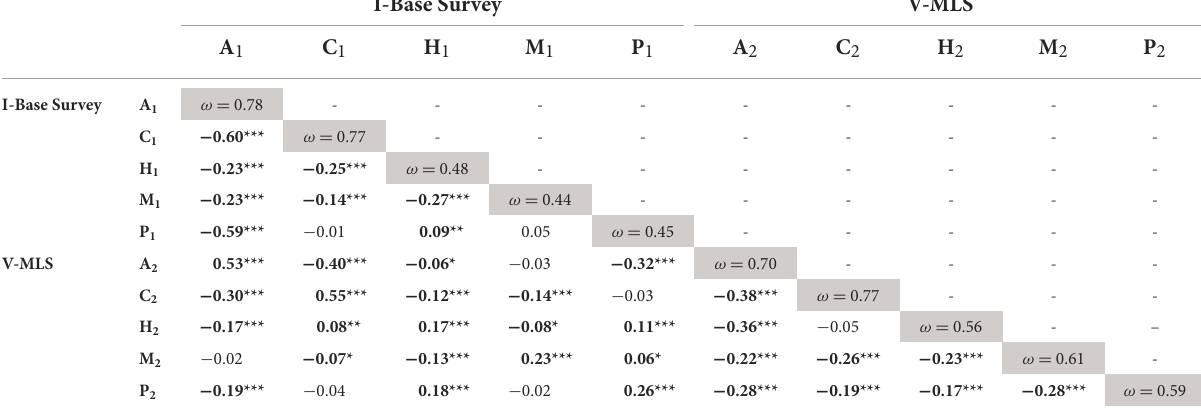
TABLE 3 Multi-trait multi-method matrix for I-Base Survey and V-MLS.